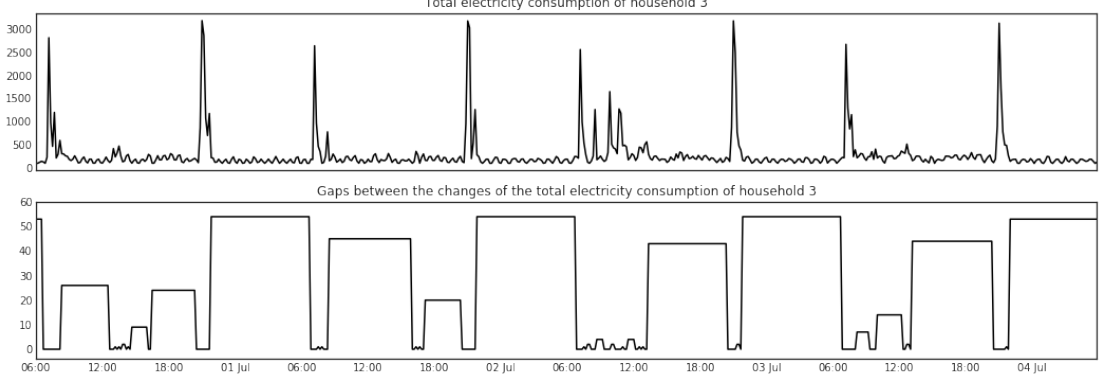
Figure 7. Gaps between change points in the electricity readings from the CT clamp connected to the electricity main of Household 3.